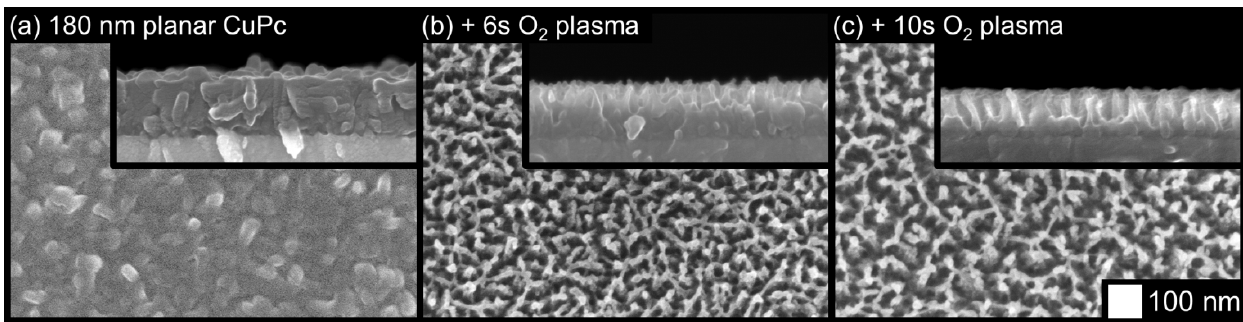
Figure 2. Effects of oxygen plasma etching on a planar CuPc thin film.